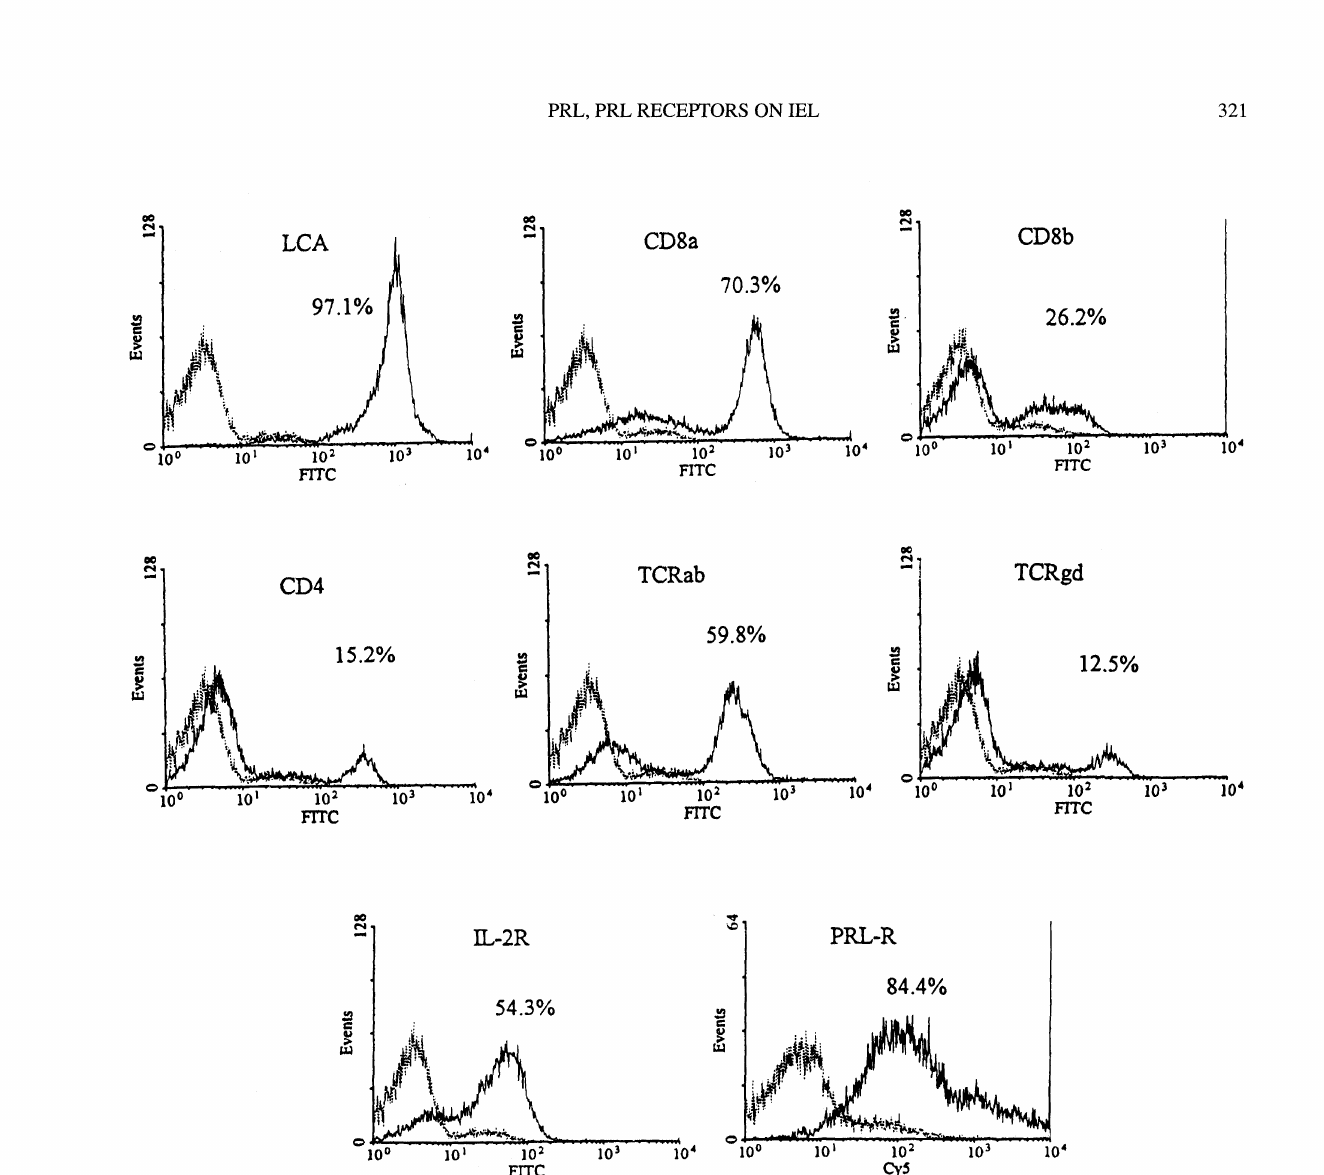
FIGURE 2 Flow cytometric characterization of IEL. IEL were isolated from the small intestine of Sprague Dawley rats and analyzed by flow cytometry on a Coulter XL2 flow cytometer with Elite software. LCA expression was used to gate the lymphocyte population. Representa- tive data from a 96 day male rat are shown. Dashed lines show the negative controls and solid lines show staining with the various lymphoid markers and PRL-R. Values are the percentages of positively stained